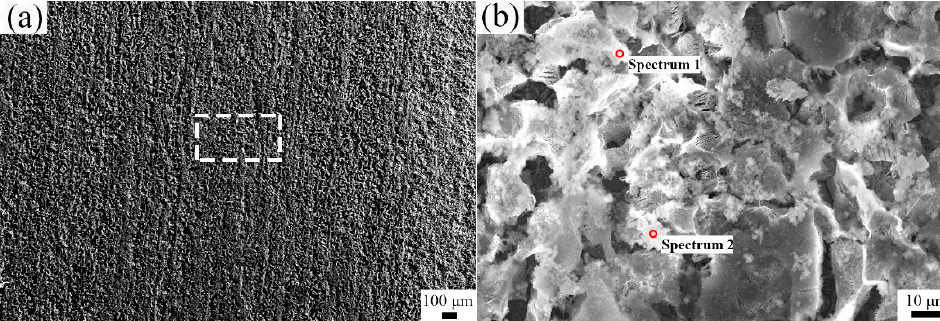
Figure 8. ( a ) SEM image of the corrosion scale of L245N standard steel and ( b ) the enlarged image of the selected area marked in ( a ) after 4 days of testing. Table 5. EDS results of the corrosion scale formed on L245N standard steel after 4 days of testing, (at. %). The spectrum labels correspond to Figure 8b.